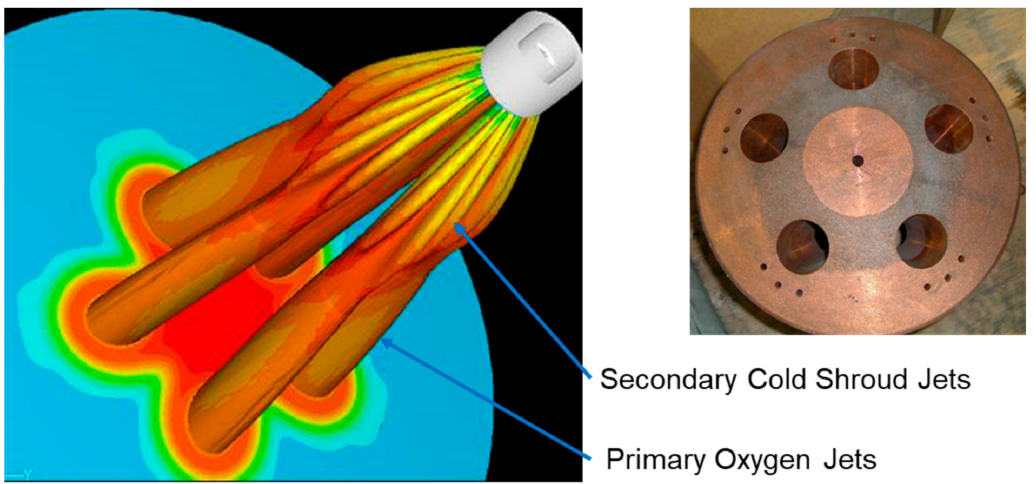
Figure 14. The principle of Cold Shroud © technology. Reprinted with permission from Refs. [66,67], 2022,